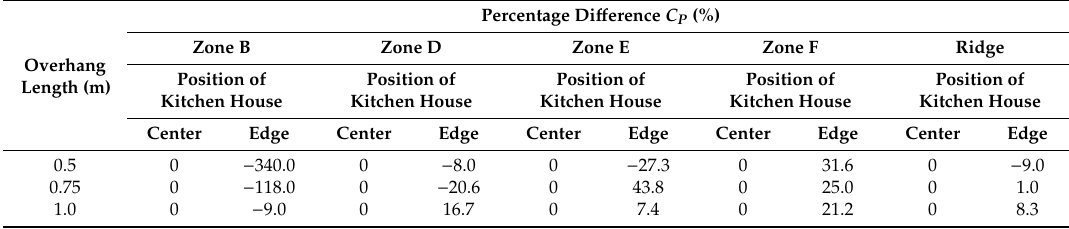
Table 5. Percentage difference of pressure coefficients for different kitchen positions.